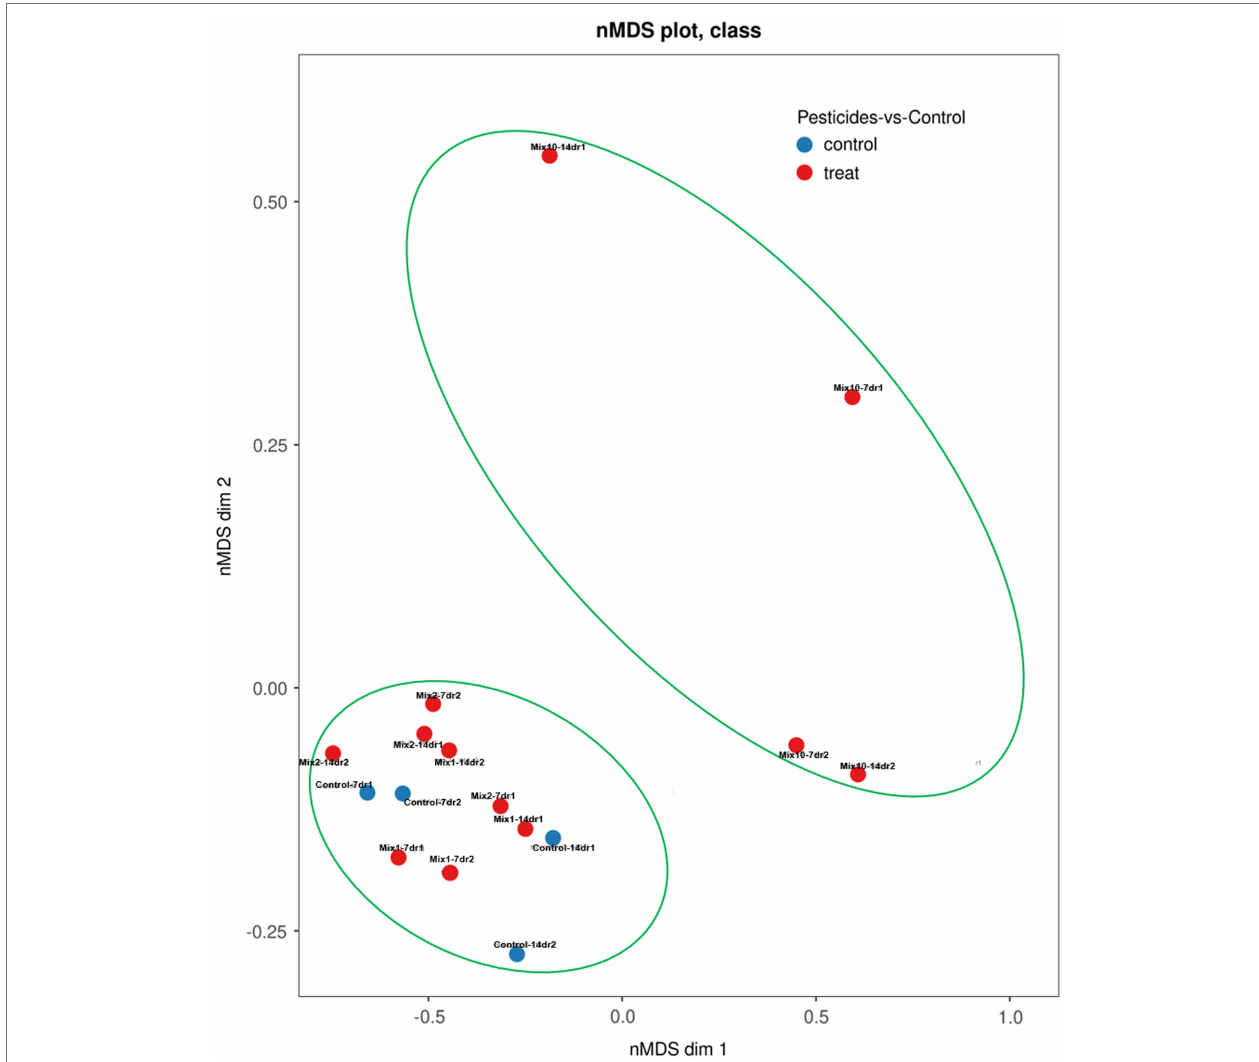
FIGURE 6 | Non-metric multidimensional scaling plot of the assembly patterns of prokaryotic communities of the earthworm’s gut using the Bray–Curtis (BC) distance matrix at the genus